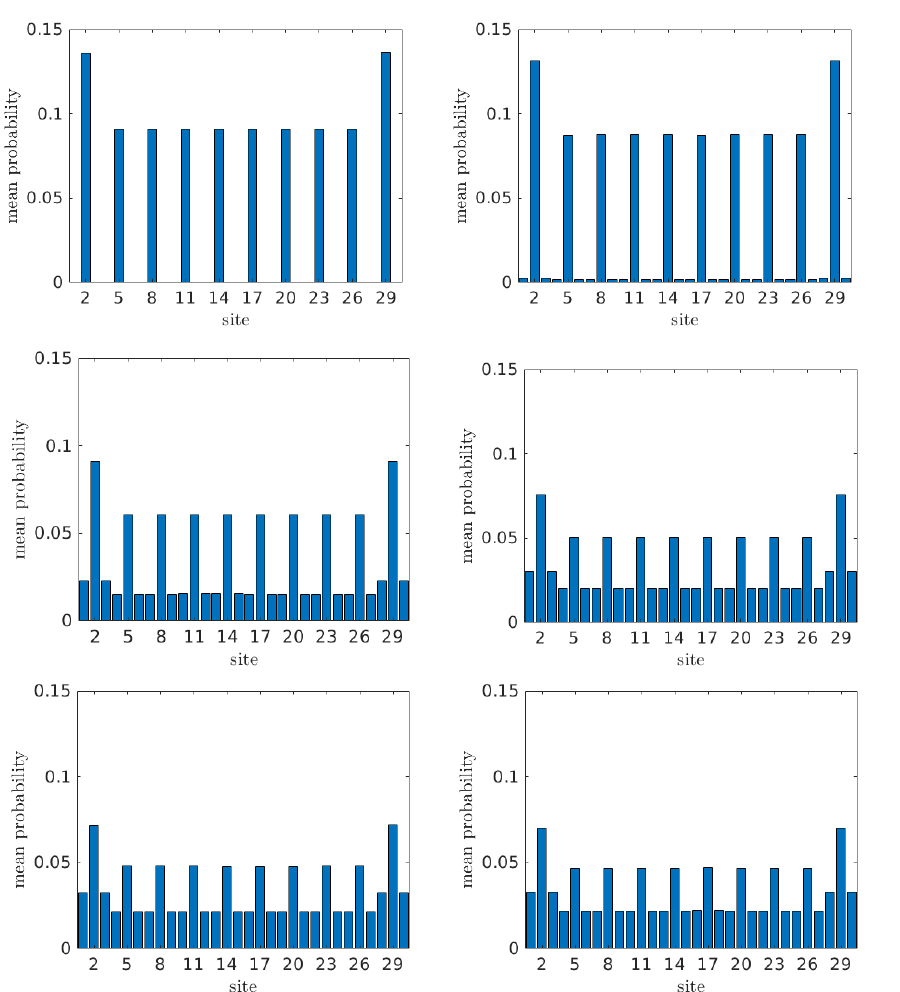
Figure 4. The mean-over-time probability at each site β , (cid:104)| C β ( t ) | 2 (cid:105) for a G... homopolymer